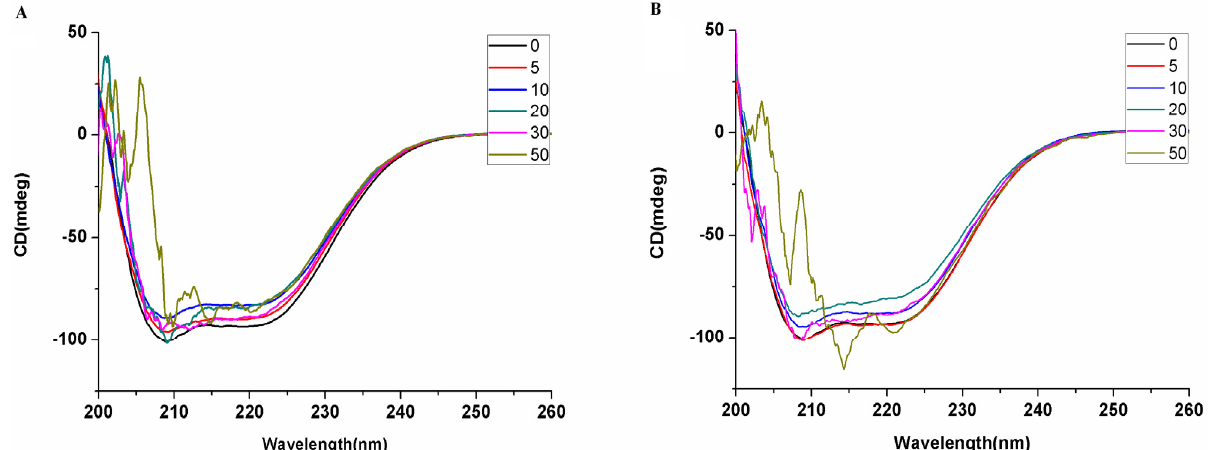
Figure 5. CD spectral changes of BSA (1 µM) on the addition of saccharide-substituted zinc phthalocyanines in water at the concentration of 0, 5, 10, 20, 30, 50